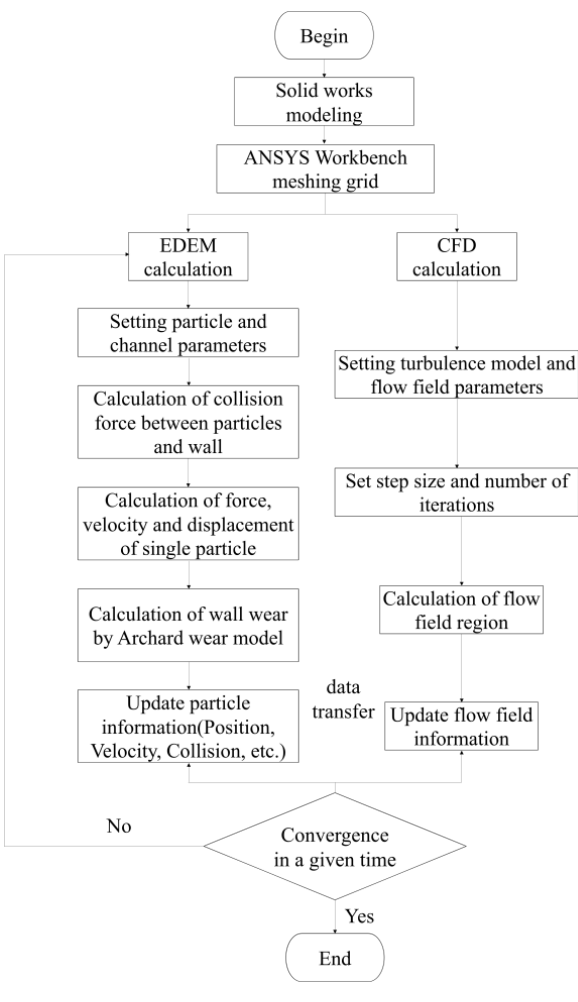
Figure 5. Coupling flow chart.